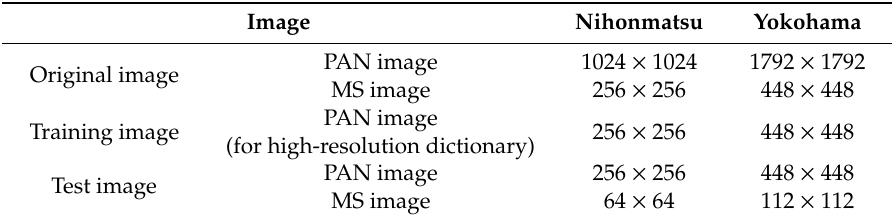
Table 1. Characteristics of the original, training, and test images of the image datasets. MS: multispectral, PAN: